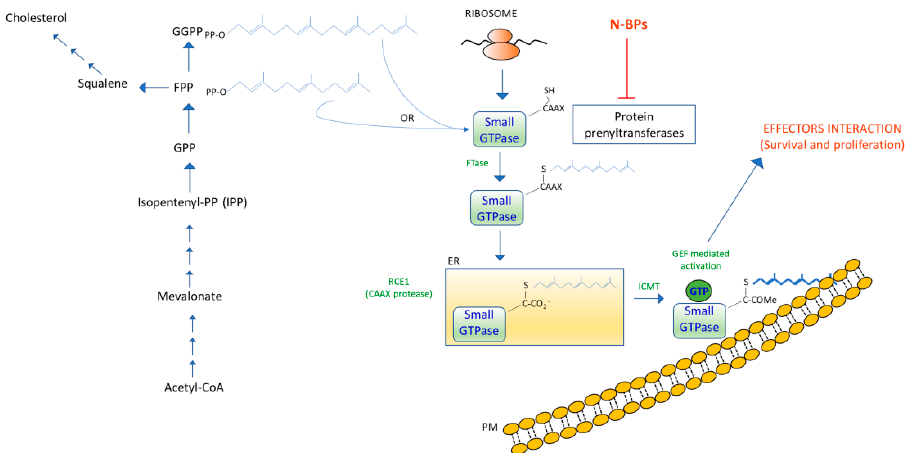
Figure 3. Schematic pathway for the small GTPase post-translational modification of prenylated proteins. Prenyltransferases attach farnesyl or geranylgeranyl lipids, derived from isoprenoid/sterol biosynthesis, to the cysteine within the C-terminal CAAX motif of small GTPase proteins, such as Ras. Nitrogen-containing bisphosphonates (N-BPs) are used to inhibit the prenyltransferases activity. The prenylated proteins undergo further modification on the cytosolic surface of the ER, by intrinsic ER membrane proteins. In particular, Ras CAAX prenyl protease 1 (RCE1) cleaves the AAX, and the resulting free carboxyl group of the prenyl cysteine moiety is methylesterificated by isoprenylcysteine carboxyl methyltransferase (ICMT), in order to target prenylated proteins to cell membrane. ER: Endoplasmic Reticulum; PM: Phospholipid Membrane.